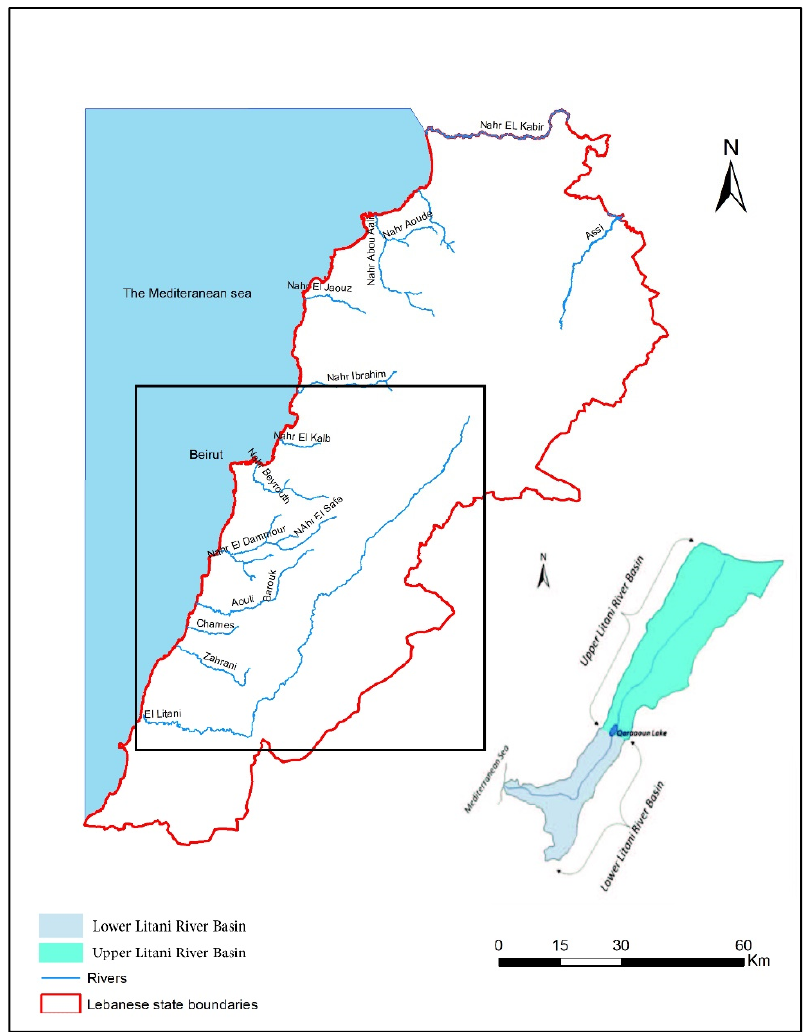
Figure 1. Litani River Basin—Lebanon.